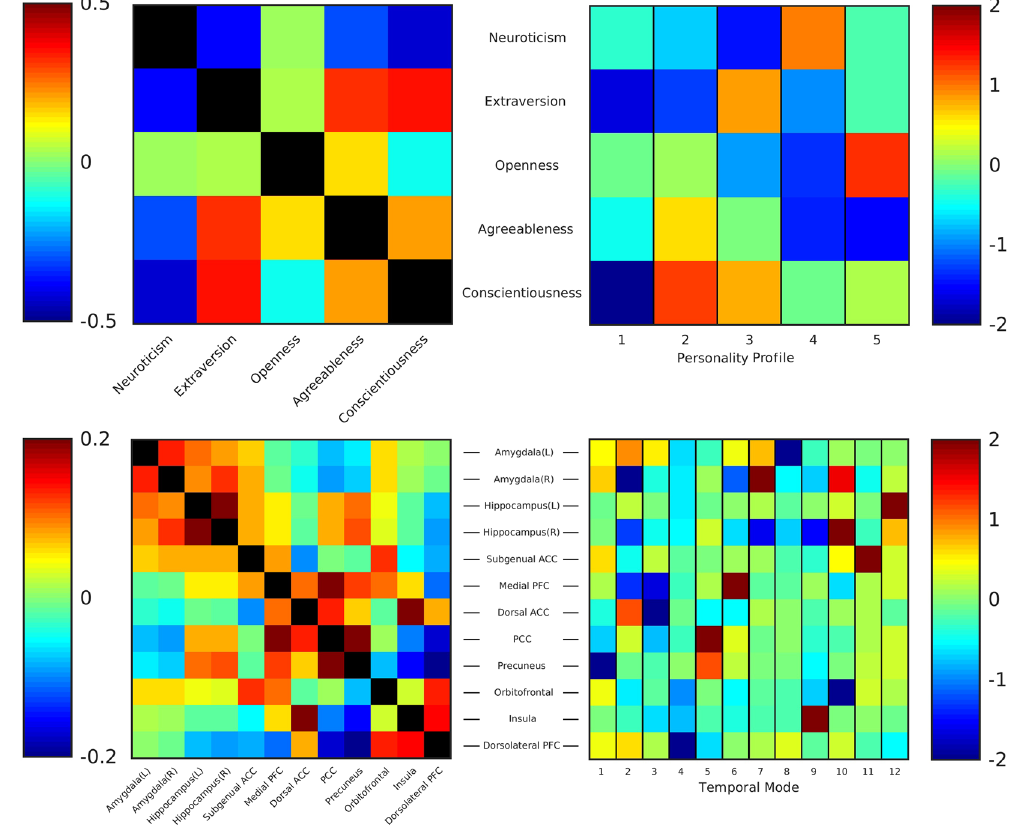
Figure 1. Personality and resting-state correlations and independent components. Top-left: full correlation matrix for the original personality factors. Top-right: normalized representation of the ICA-decomposition for the personality factors into new personality profiles. Each column shows an independent component with the loading onto the original personality factors. Bottom-left: full correlation matrix for the resting-state time series of the 12 regions-of-interest. Bottom-right: normalized representation of the ICA-decomposition for the resting-state time series. Each column shows an independent spatial pattern (or ‘temporal mode’) with loading onto the 12 regions-of-interest. Abbreviations: sgACC – subgenual anterior cingulate, mPFC – medial prefrontal cortex, dACC – dorsal anterior cingulate cortex, PCC – posterior cingulate cortex, PCu – precuneus, OFC – orbitofrontal cortex, dlPFC – dorsolateral prefrontal cortex.